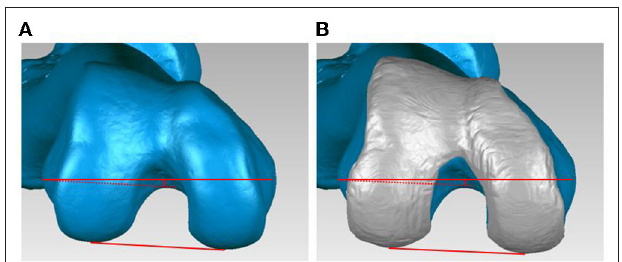
FIGURE 2 | The posterior condylar angle (PCA). The PCA was defined as the angle between the surgical transepicondylar axis and the posterior condyle line, which connects the most posterior points of the osseous and the cartilaginous contours, respectively, of the lateral and medial posterior condyles on the transverse plane perpendicular to the Y-axis. (A) PCA on the osseous contours. (B) PCA on the cartilaginous contours.